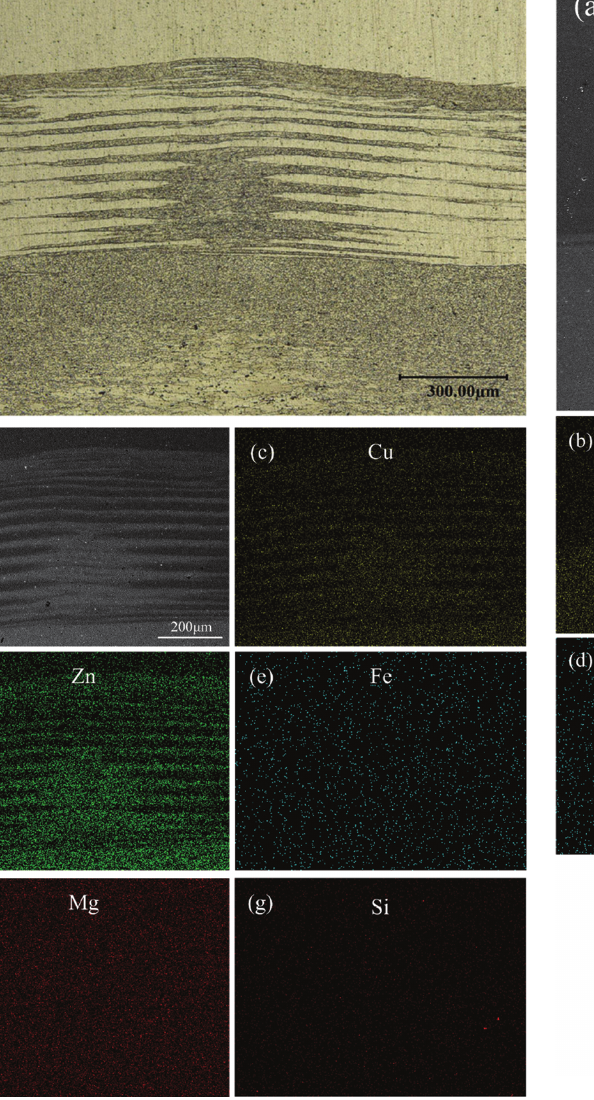
Figure 5: Microstructure of the joint using 3.4mm: (a) joint center, (b) SEM image, (c) Cu, (d) Zn, (e) Fe, (f) Mg and (g) Si.